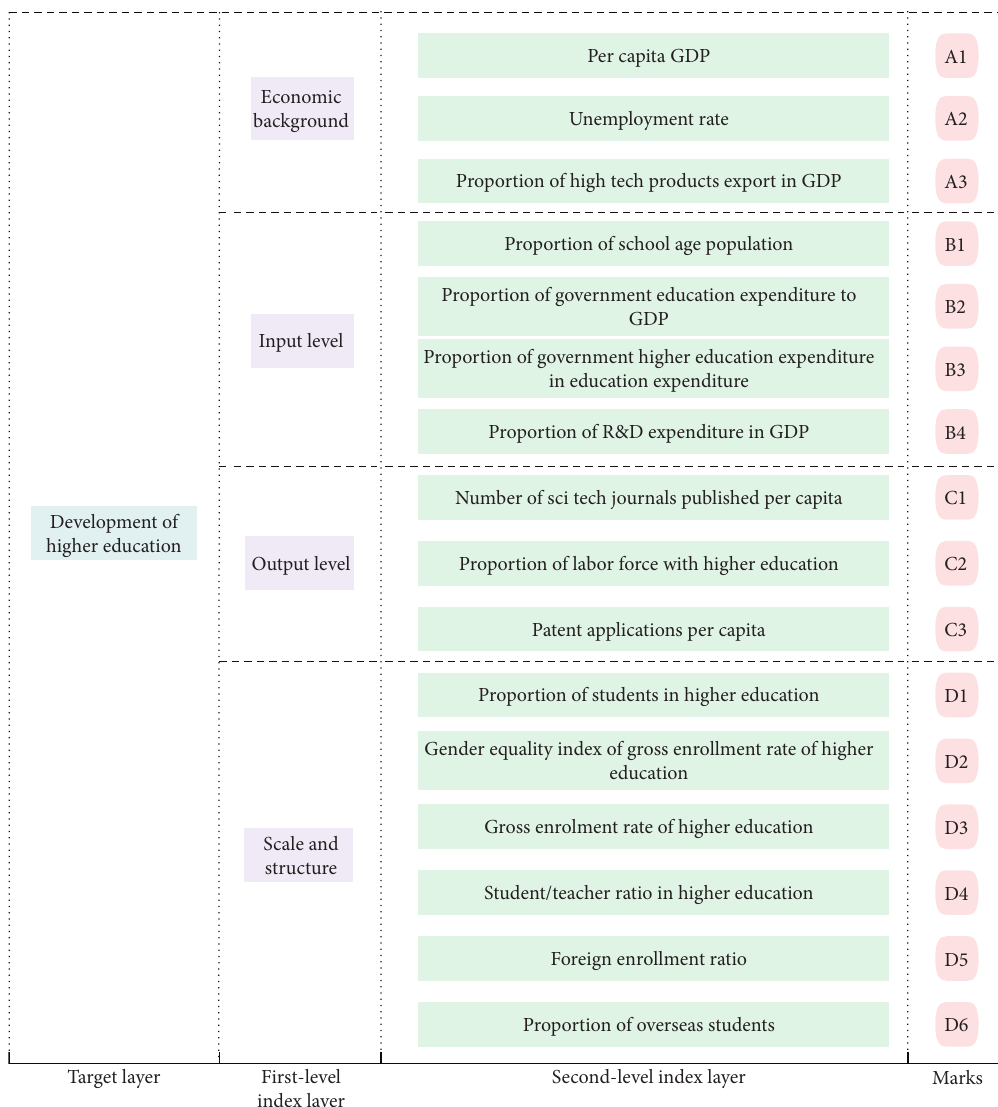
Figure 2: Comprehensive evaluation index system of development level of higher